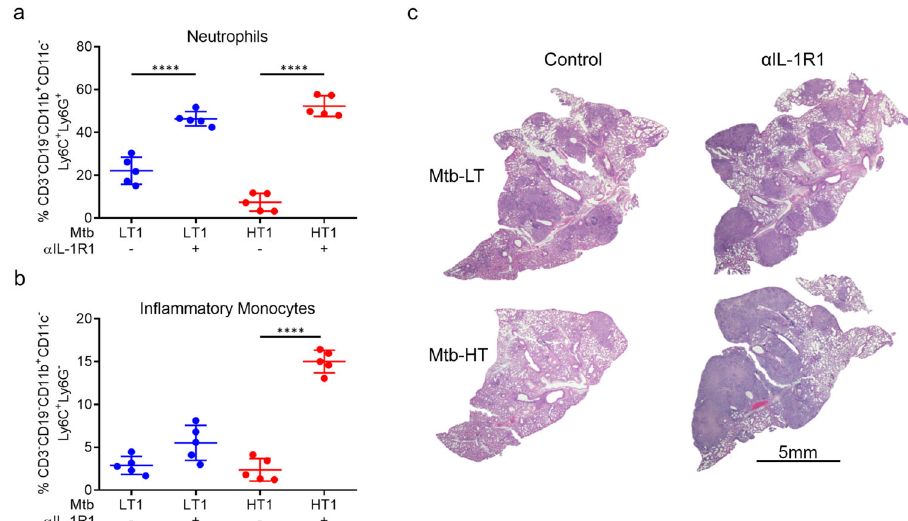
Fig. 8 Transient inhibition of IL-1R signaling results in increased pathology in Mtb-HT infected mice. C3HeB/FeJ mice were infected with ~100 CFU of the indicated strain via Glas-Col aerosol exposure. On days 8, 10, and 12 post infection 200ug α -IL-1R1 ( + ) or isotype control ( − ) was administered to the mice. At 4 weeks post infection mice were sacri fi ced and the right middle and inferior lung lobes were isolated to obtain single cells. Following perfusion, the left lobe was formalin- fi xed, paraf fi n-embedded, and hematoxylin and eosin staining were carried out. Data are presented as percent of neutrophils ( a ) and in fl ammatory monocytes ( b ). Data are presented as mean values + / − SD. Source data are provided as a Source Data fi le. Representative H&E-stained lung sections for the indicated strains at week 4 post infection with and without transient IL-1R signaling. Scale bars: 5 mm ( c ). Five mice were included in each group. Signi fi cance was determined using one-way ANOVA with Tukey ’ s correction. **** P <